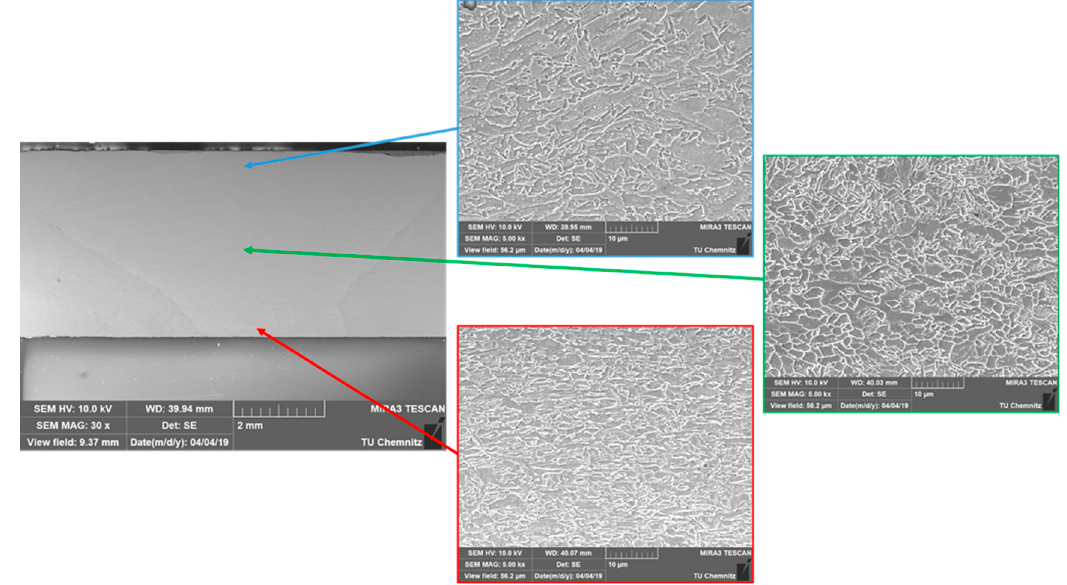
Figure 8. SEM images of the developing microstructures in the weld metal by a torch to roller distance of 105 mm.